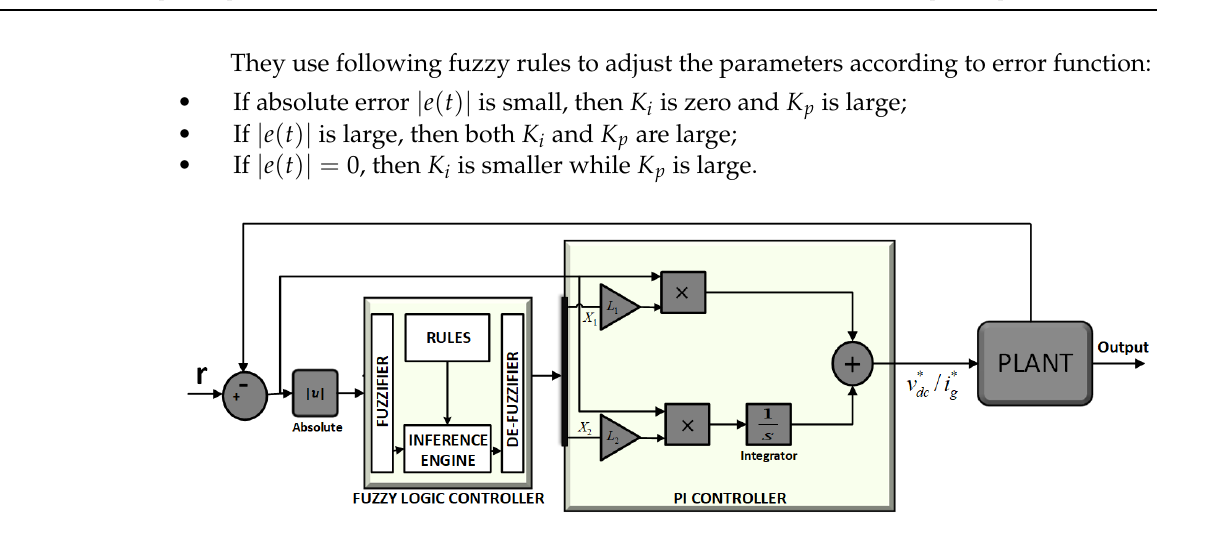
Figure 4. Adaptive PI